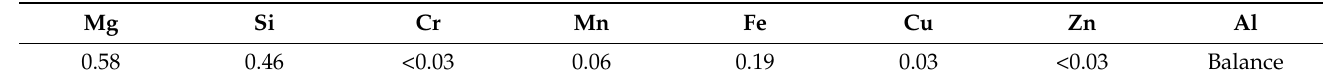
Table 1. Chemical composition of 6063 aluminum alloy w/%.